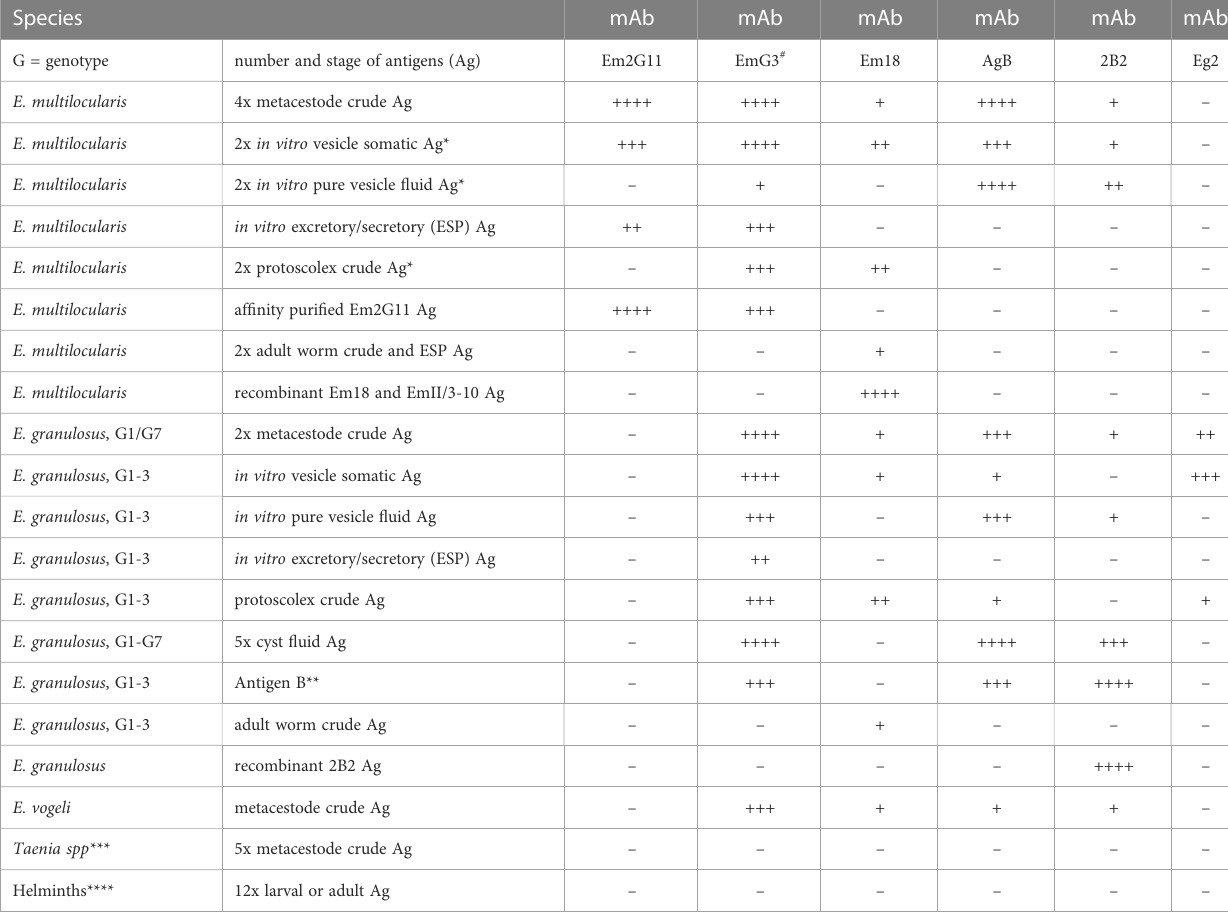
TABLE 2 Antigen binding of monoclonal antibodies on various parasitic antigens in direct